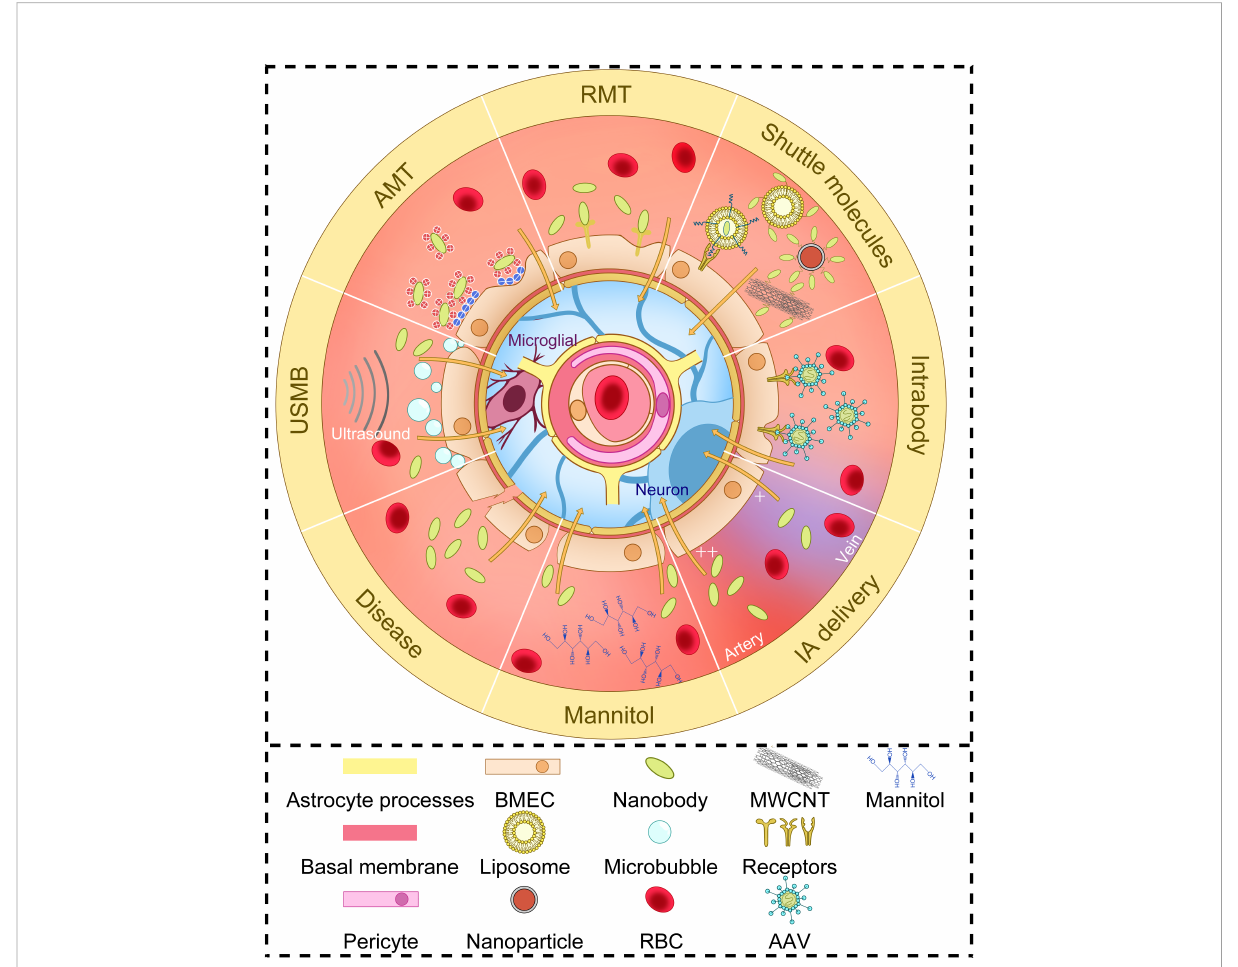
FIGURE 2 The structure of neurovascular units and several ways to increase BBB delivery of nanobodies. Brain-microvessel endothelial cells (BMECs), astrocytes, pericytes, capillary basal membrane, microglia, and neurons make up neurovascular Units (NVU). The ef fi ciency of nanobodies crossing the BBB depends on altering BBB permeability or some physiological mechanisms of BBB crossing. AMT, adsorptive-mediated transcytosis; RMT, receptor-mediated transcytosis; USMB, ultrasound and microbubble; MWCNT, multi-walled carbon nanotubes; AAV, adeno- associated virus vectors; RBC, red blood cell; IA,